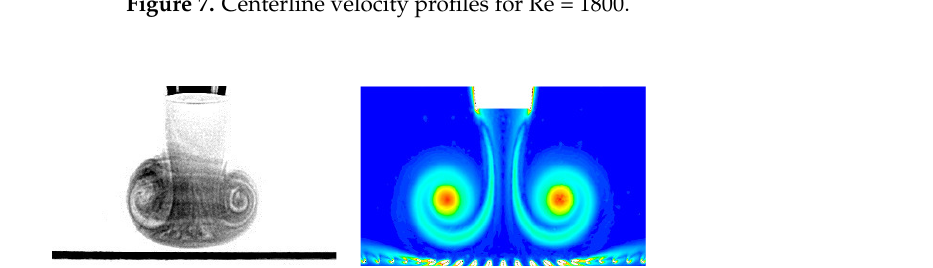
Figure 7. Centerline velocity profiles for Re = 1800.